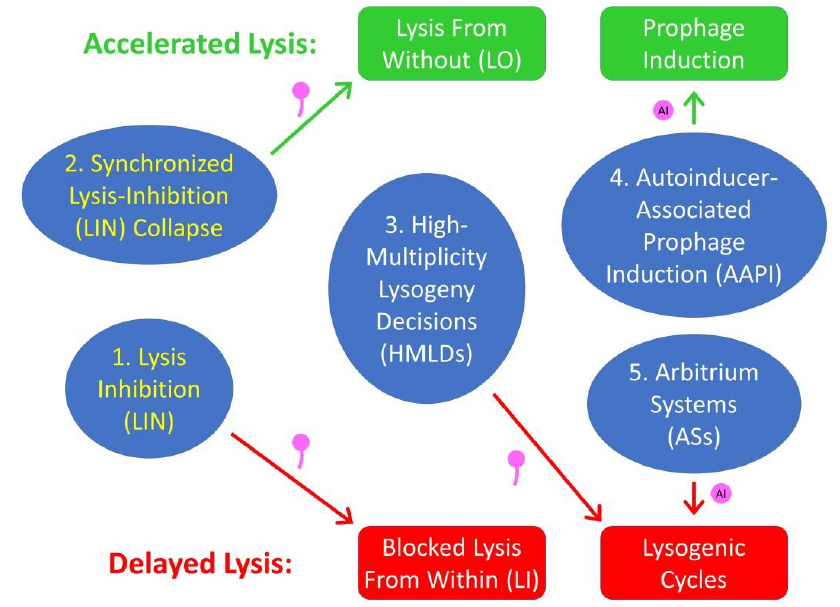
Tables 1 and 2 for a summary of abbreviations and concepts used in the article.